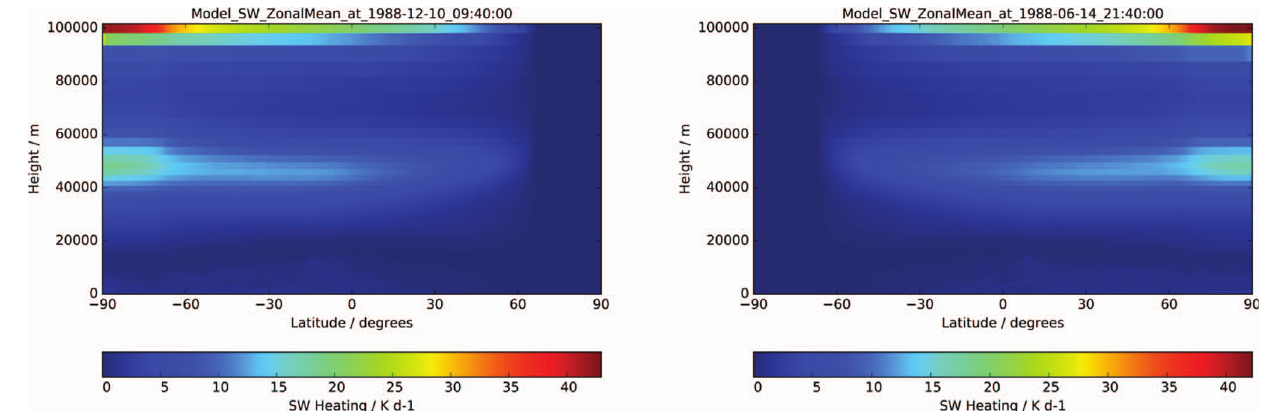
Fig. 6. Plots illustrating the issue evident with the SW radiation produced by the radiation scheme. We see abnormal values in exactly the regions where the high wind speeds occur in the previously discussed model runs. (a) Zonal mean of the SW radiative heating for the model run starting in September and crashing in December. (b) Zonal mean of the SW radiative heating for the model run starting in March and crashing in